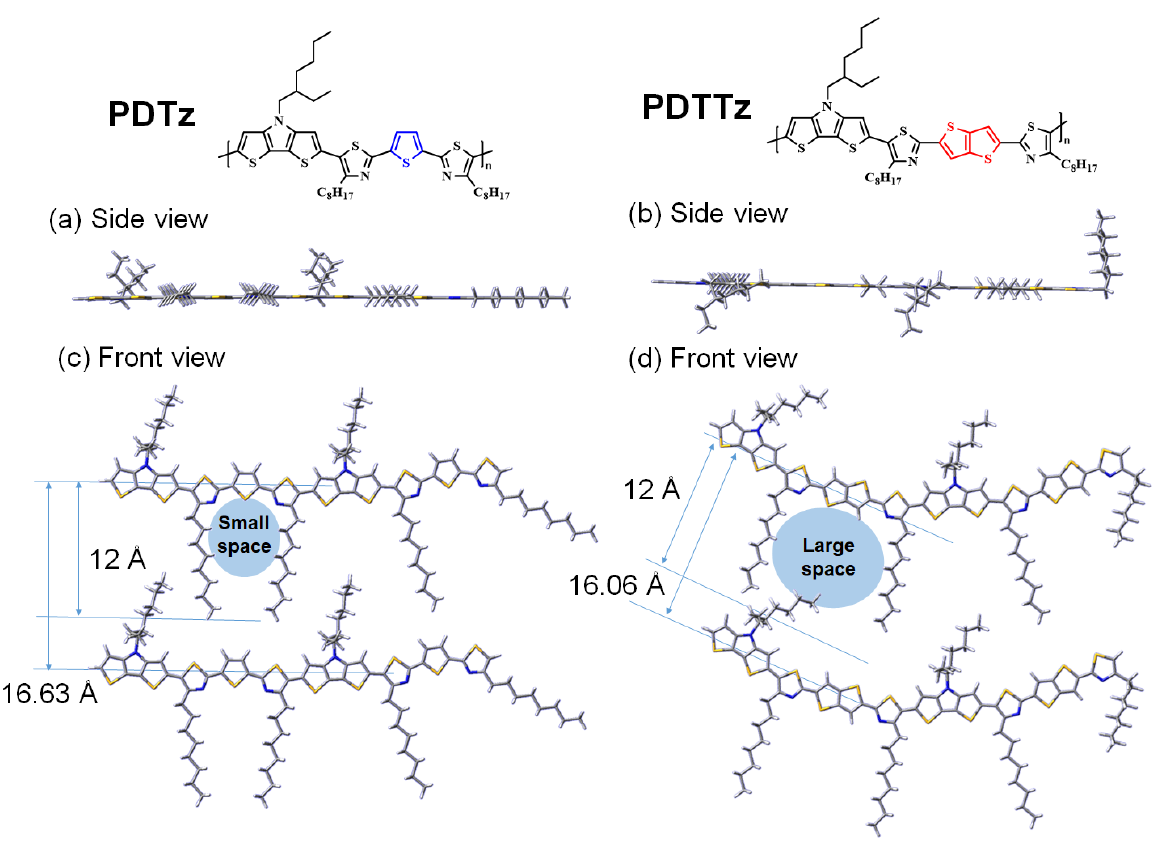
Figure 6. Optimization of the dimer structure of polymer repeat units via DFT calculation. Side view of the optimized ( a ) PDTz and ( b ) PDTTz structures. Estimated space within the lamellar structure of ( c ) PDTz and ( d ) PDTTz.